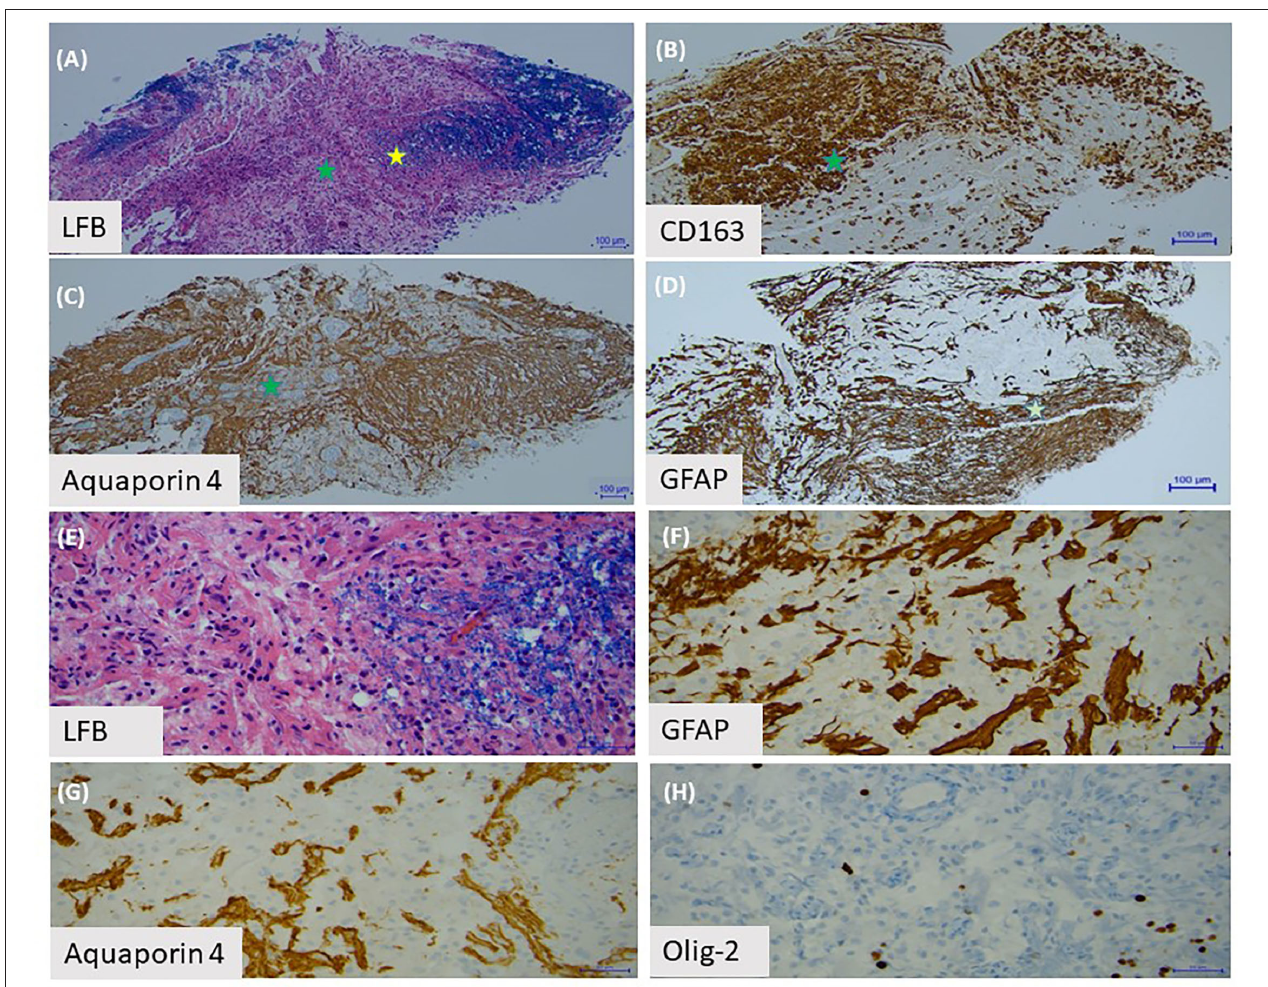
FIGURE 2 | Brain biopsy with (A) Luxol Fast Blue staining of myelin shows a sharply demarcated area of myelin loss. (B) This area is infiltrated by lipid-laden macrophages, labeled by CD163. (C) The area with the green star demonstrates partial loss of aquaporin-4 astrocytes. (D) There is also depletion of GFAP positive astrocytes in this area. (E) Under high power (yellow star area on first slide), we observed the edge of the demyelinated lesion. (F) There are sparse GFAP positive astrocytes and (G) aquaporin-4 positive astrocytes present around blood vessels. (H) Olig-2 stain shows loss of oligodendrocytes.